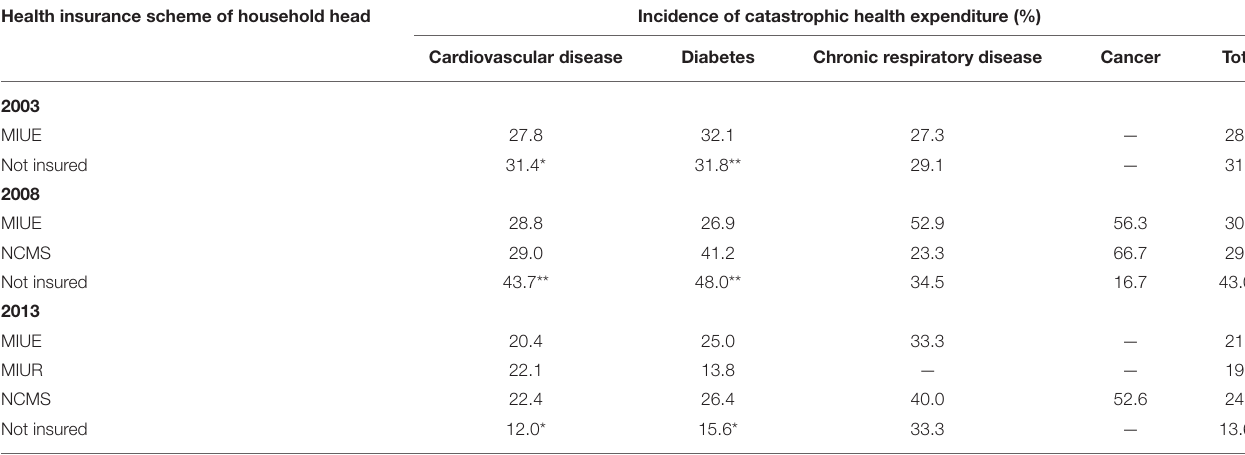
TABLE 3 | Distribution of catastrophic health expenditure for different types of NCD households in different health insurance schemes. Health insurance scheme of household